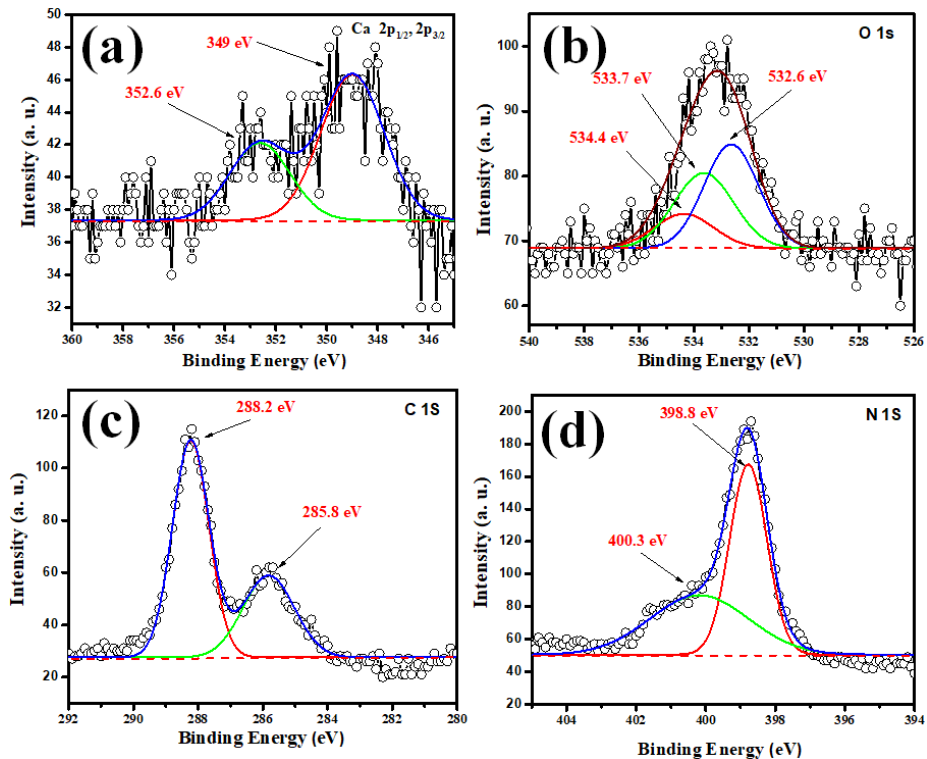
Figure 5. XPS spectra of ( a ) Ca-2p; ( b ) O 1s; ( c ) C 1s and ( d ) N 1s for CaO@g-C 3 N 4 nanosorbent.